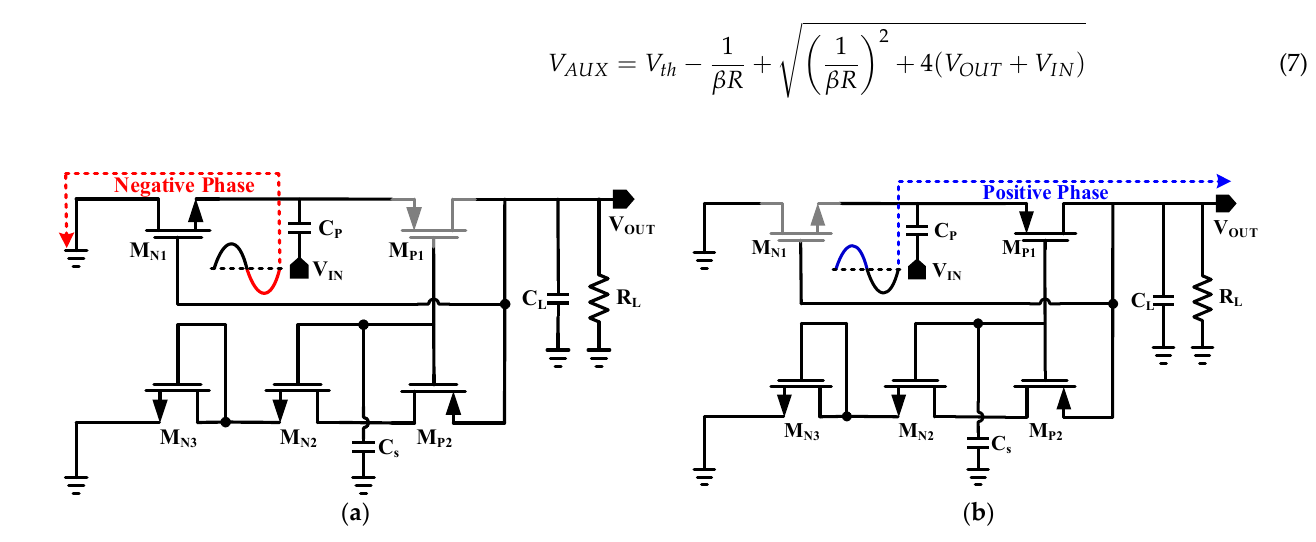
Figure 4. Operating principle of the RF-DC converter. ( a ) Charging (negative) phase. ( b ) Discharging (positive) phase.